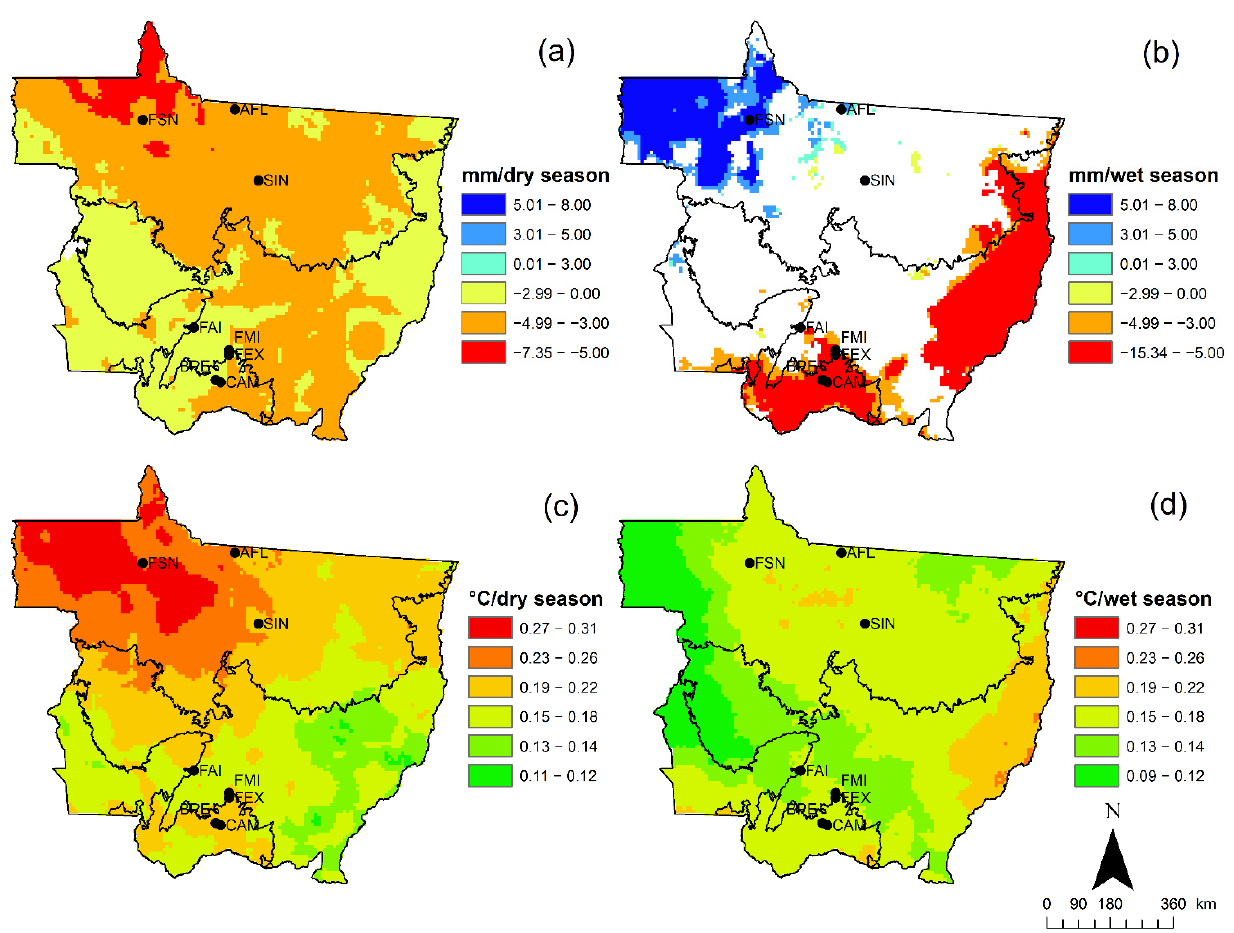
Figure 10. ERA-5 precipitation trend per dry ( a ) and wet ( b ) season and temperature trend per dry ( c ) and wet ( d ) season for the last 40 years for the state of Mato Grosso. White space means non-significant trends.